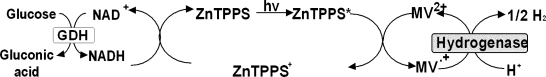
Hydrogen production system consisting of glucose, GDH, NAD+ and hydrogenase.